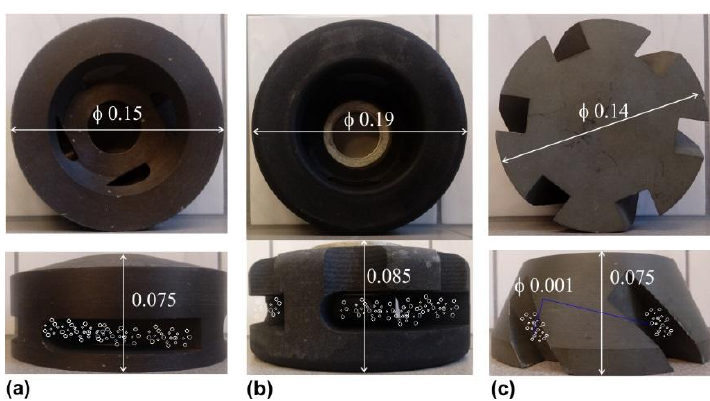
Figure 2. View of the rotary impellers applied in the measurements: ( a ) commercial impeller design A; ( b ) new impeller design B; ( c ) commercial impeller design C. Unit: m.